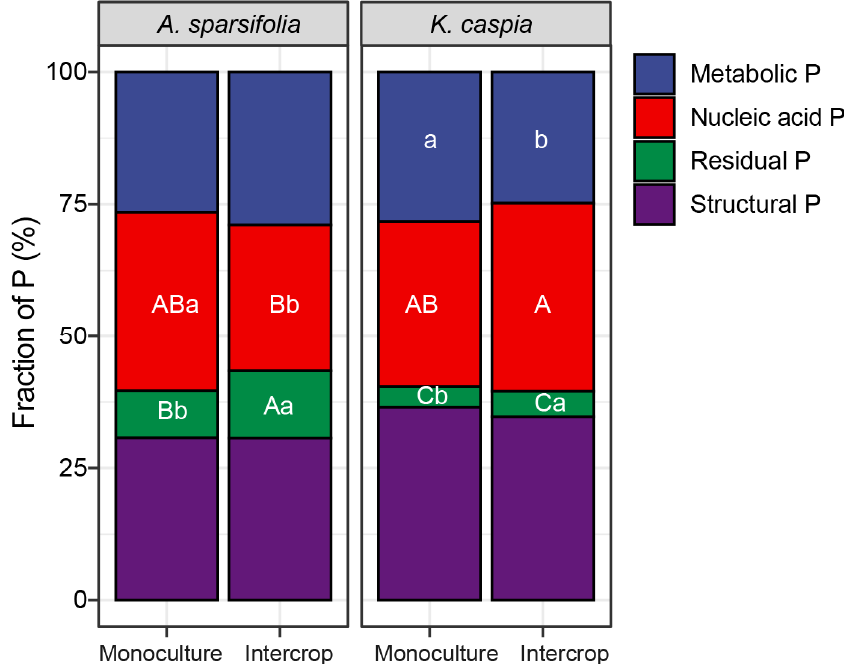
Figure 7. Percentage of different foliar P fractions in total P (the sum of all P fractions) in plants of A. sparsifolia and K. caspia monocultures and their intercrop (four groups). Values are means (n = 5). Different letters in error bars indicate significant differences at p < 0.05 among the four groups. Different capital letters indicate significant differences at p < 0.05 among four treatments, and lowercase letters indicate significant differences at p < 0.05 among different plant communities ( Alhagi sparsifolia (legume) monoculture, Karelinia caspia (non-legume) monoculture, and both species intercropped).